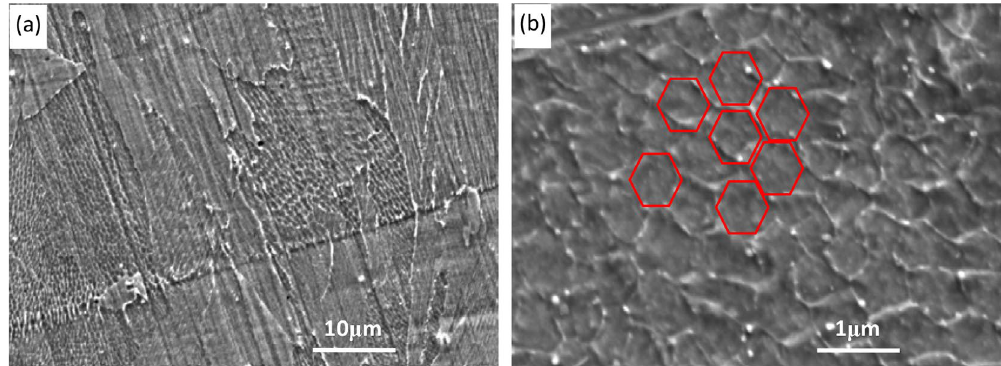
Figure 12. SEM images of typical LPBF GH3536 along BD: ( a ) polycrystalline substructure; ( b ) single crystal substructure.